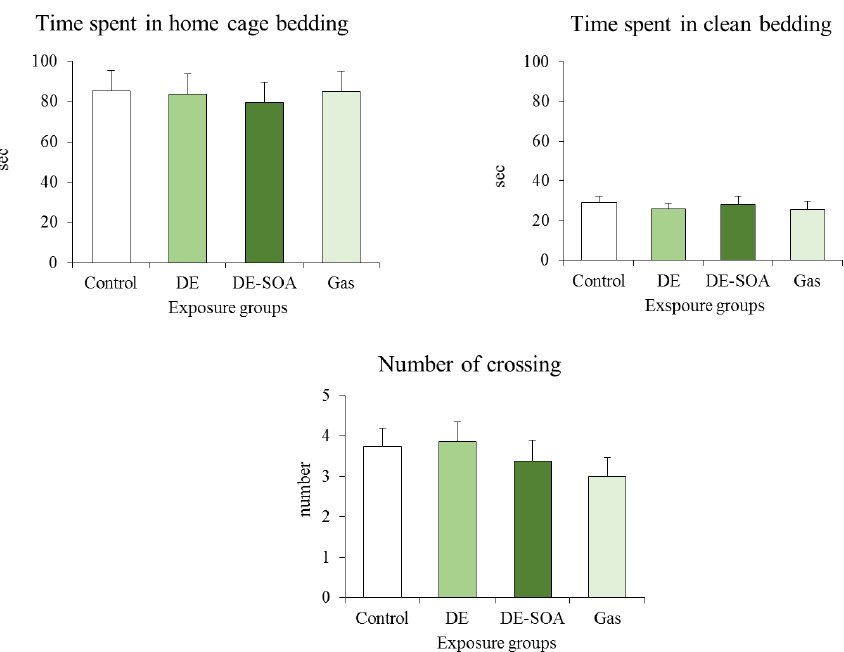
Figure 3. Odor discrimination and motor function test in PND 11 preweaning mice ( n =